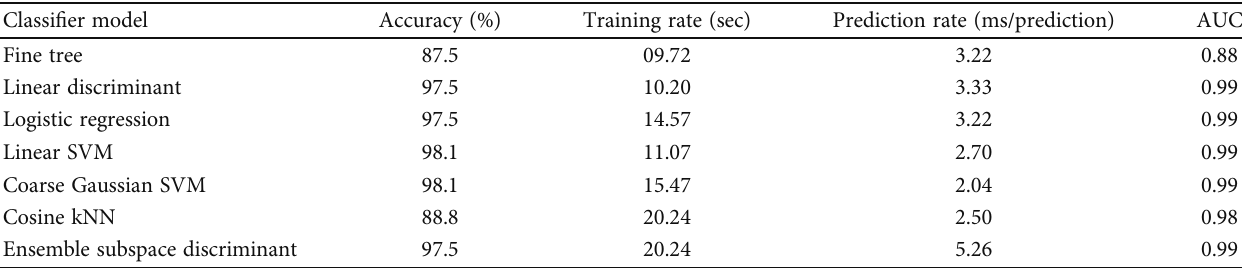
Table 6: The performance comparison (machine learning